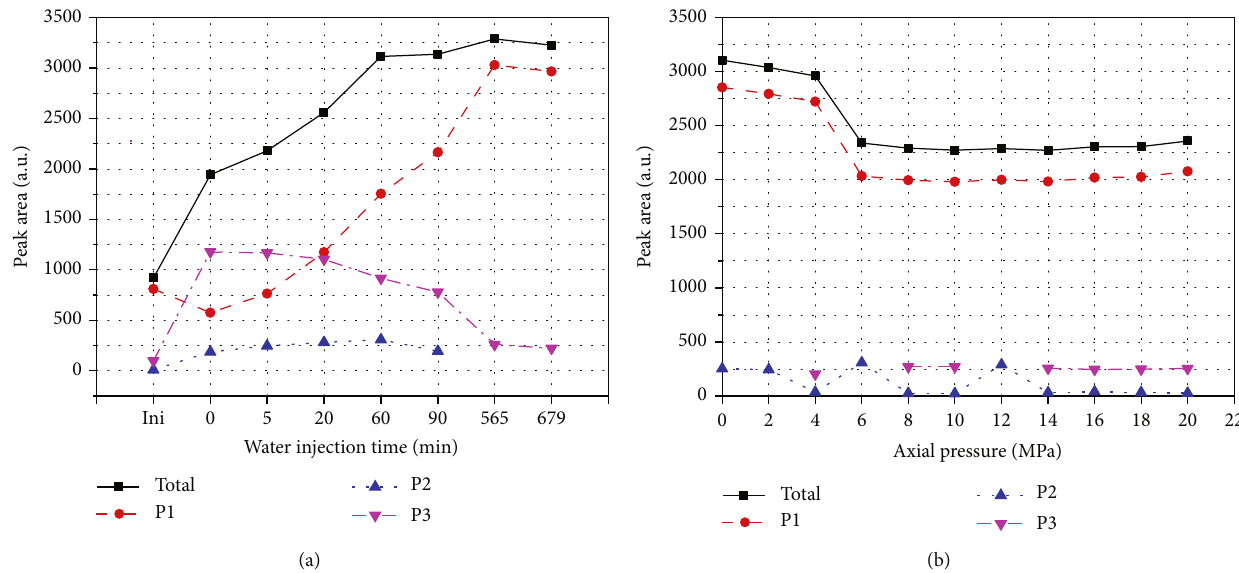
Figure 8: T 2 spectrum area of each peak. (a) Water injection process. (b) Triaxial compression